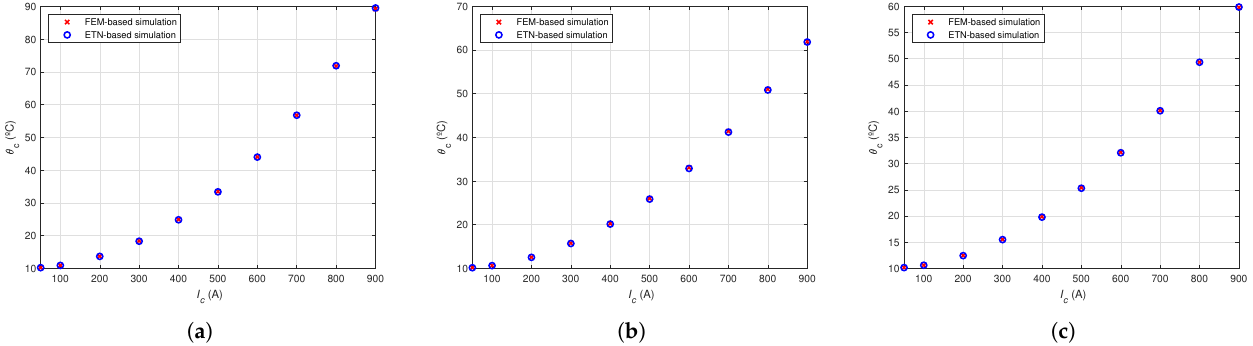
Figure 19. Estimation results with θ amb = 10 ◦ C, d p = 1 m and k soil = 1 W/(K · m) for: ( a ) Cable 1E; ( b ) Cable 2R; ( c ) Cable 2E.